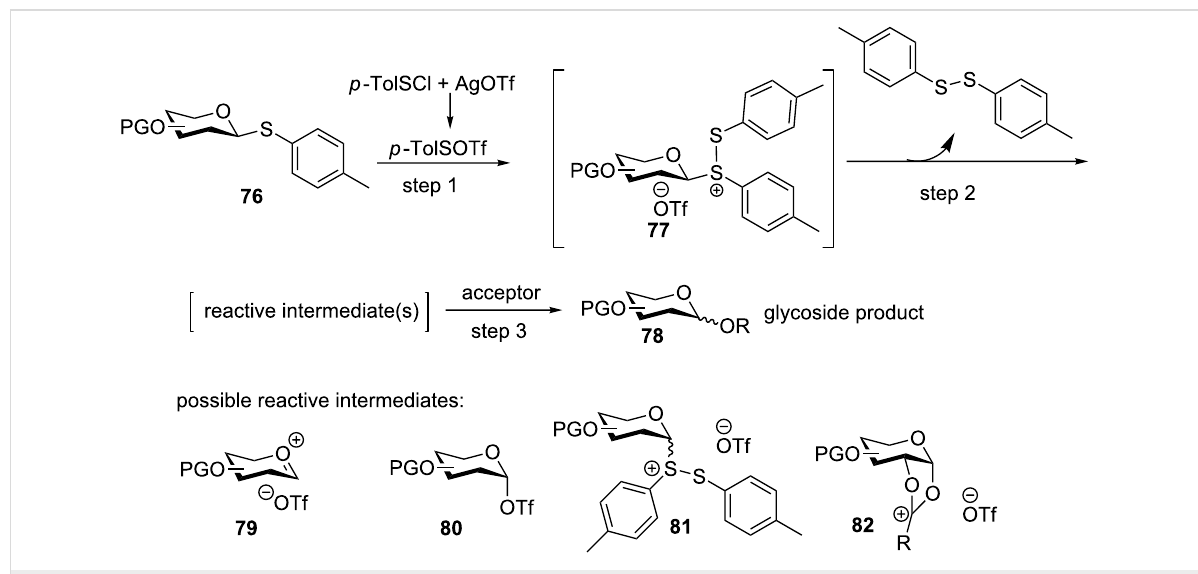
Scheme 15: Proposed mechanism for preactivation-based glycosylation